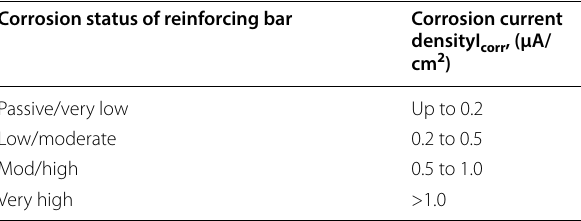
Table 4 State of corrosion on steel bar based on corrosion current density (Millard 2003).